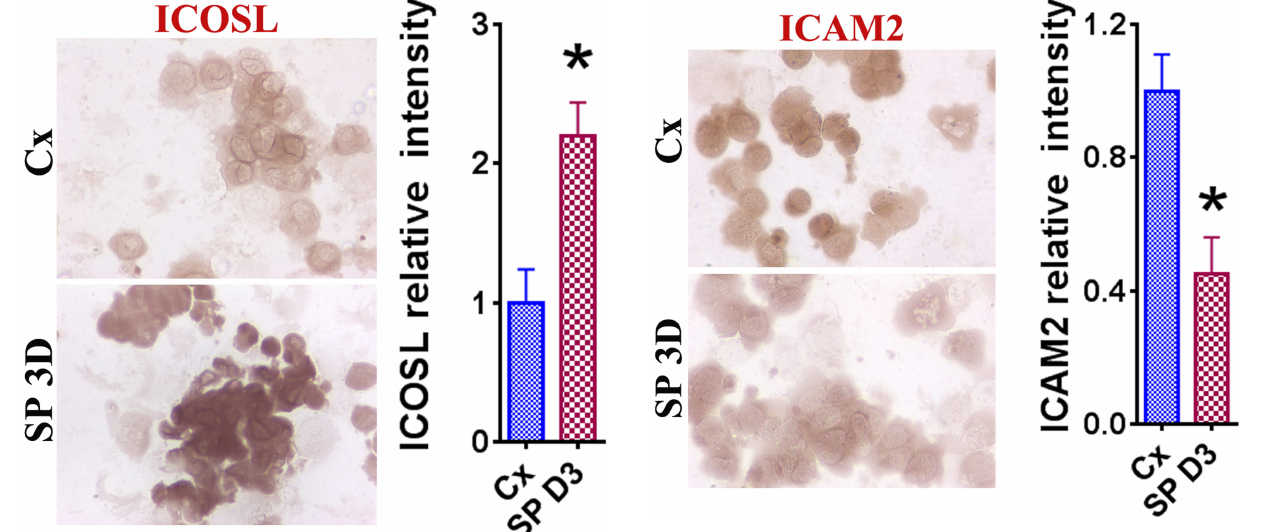
Fig. 3. The effect of SP on the expression of ICOSL in LNCaP cells evaluated by IHC staining. There was an increase in stain- ing intensity observed in the group treated with SP versus the con- trol group, demonstrating an increase in the expression of ICOSL. On 3 slides, 3–5 high power fields were selected randomly, and the relative staining intensities were assessed using MetaMorph image analysis software. Shown are the original 400 × magnifica- tion IHC images. Statistically significant results are indicated by asterisk (*) ( p < 0.05).